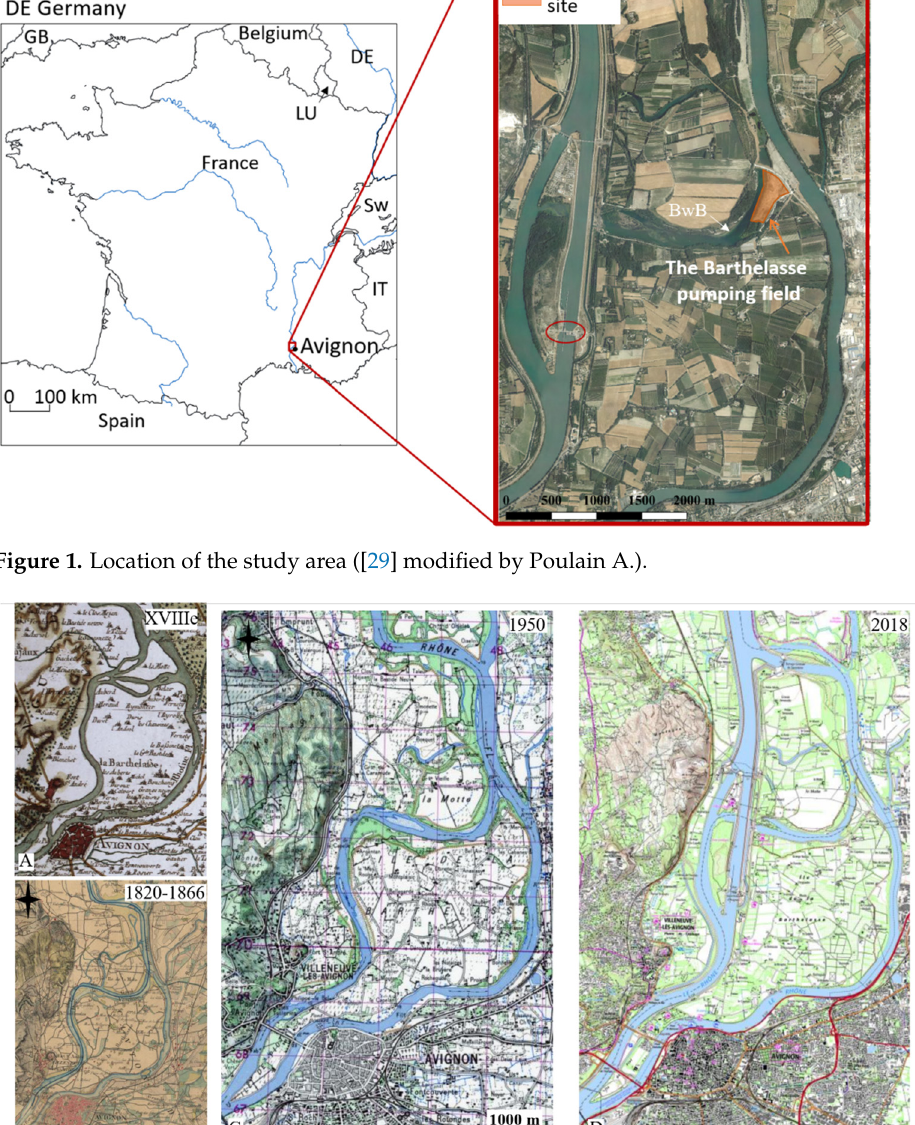
Figure 1. Location of the study area ([29] modified by Poulain A.).